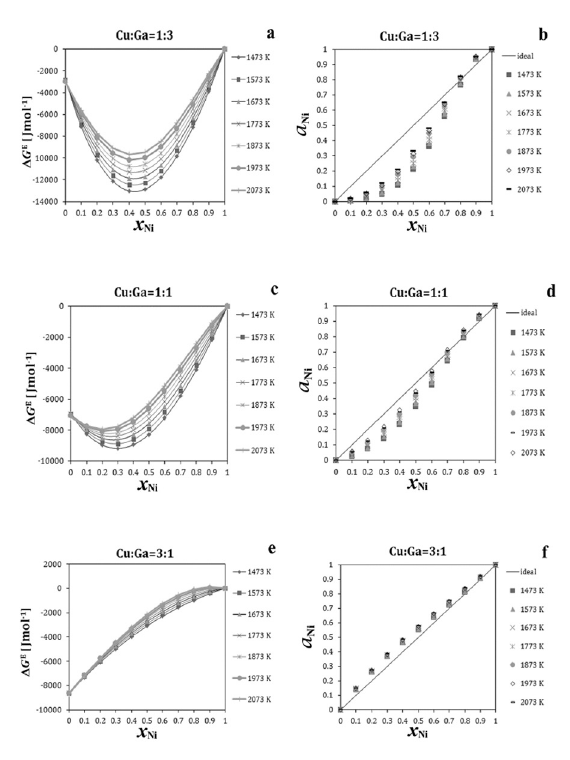
Figure 4: Results of thermodynamic calculation according to GSM in temperature range of 1473-2073K for cross-sections from nickel corner: a) integral molar excess Gibbs energy (ΔG E ) and b) nickel activity for cross section Cu:Ga=1:3; c) Δ G E and d) nickel activity for cross section Cu:Ga=1:1; e) Δ G E and f) nickel activity for cross section